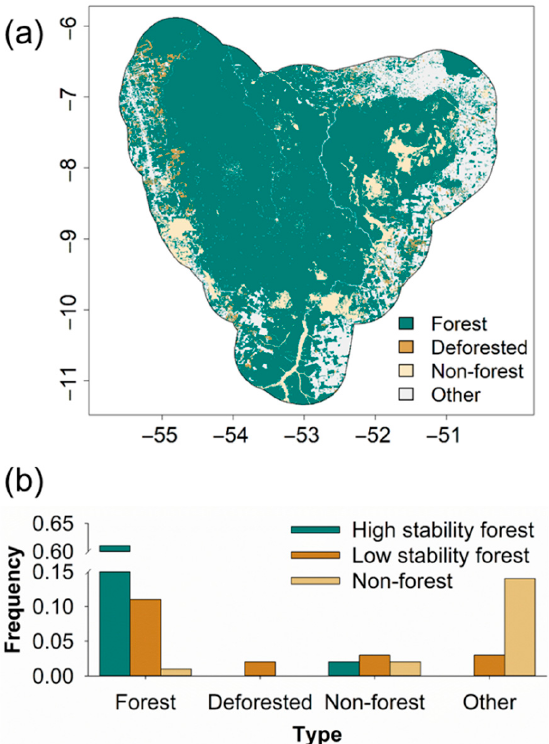
Figure 6. ( a ) Deforestation map for the Kayapó territory (Brazil) corresponding to the year 2018. ( b ) Frequency distribution of forest stability classes across land-cover types shown in ( a ).